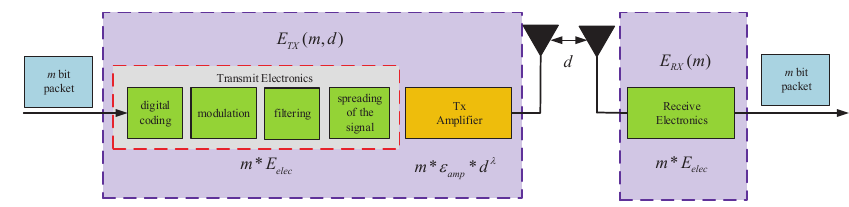
Figure 2. Radio energy dissipation